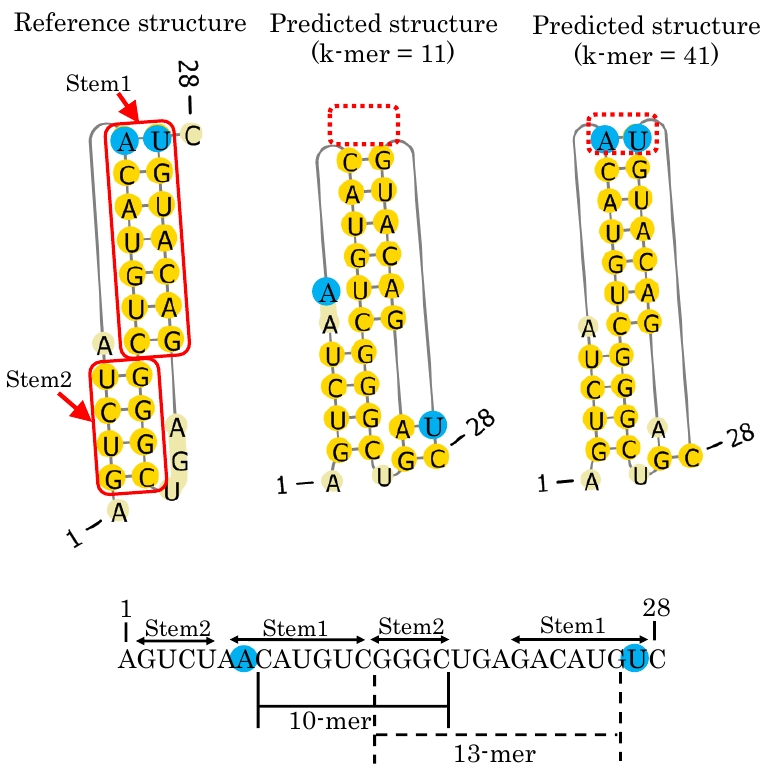
Figure 7. ( Top ) Comparison between the reference structure of ID PKB189 ( top-left ) and the predicted structures with context lengths k = 11 ( top-middle ) and k = 41 ( top-right ). ( Bottom ) Distance between two stems (Stem 1 and Stem 2) in the pseudoknotted